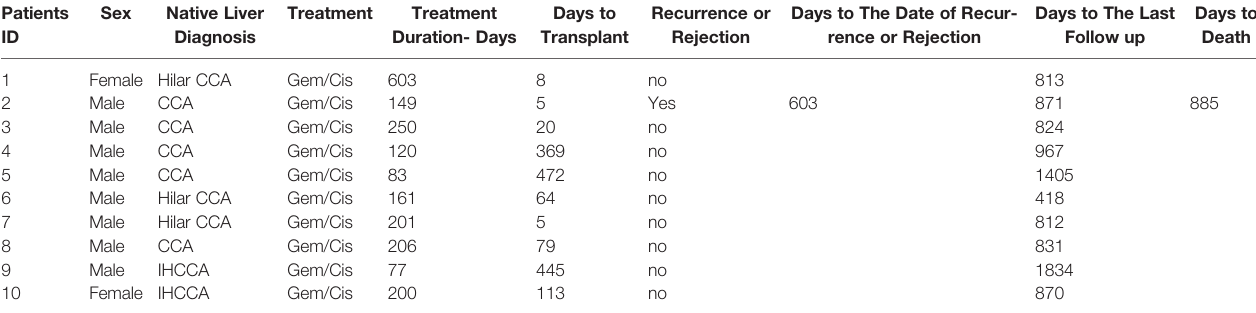
TABLE 1 | Transplant related outcomes in patients who received Gemcitabine plus Cisplatin as neo-adjuvant treatment for cholangiocarcinoma prior to liver transplantation. Patients ID